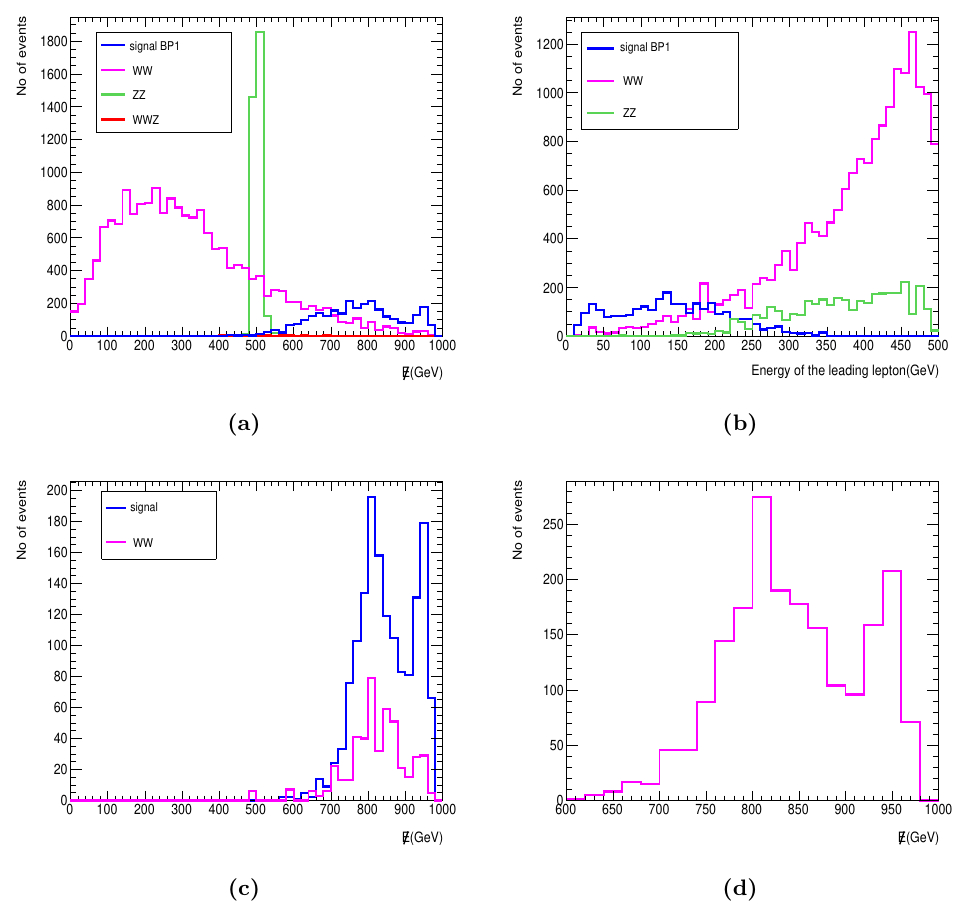
Figure 12. Unnormalized distribution of (a) missing energy, (b) energy of the leading lepton, (c) missing energy after applying the cut on the energy of leading lepton < 150 GeV for DM signal and SM backgrounds, (d) missing energy distribution of signal from BP1 plus background after √ applying the cut E 150 GeV at ILC with s = 1 TeV, beam polarisation P3 (see text) at ‘ 1 < L = 1000 fb − 1